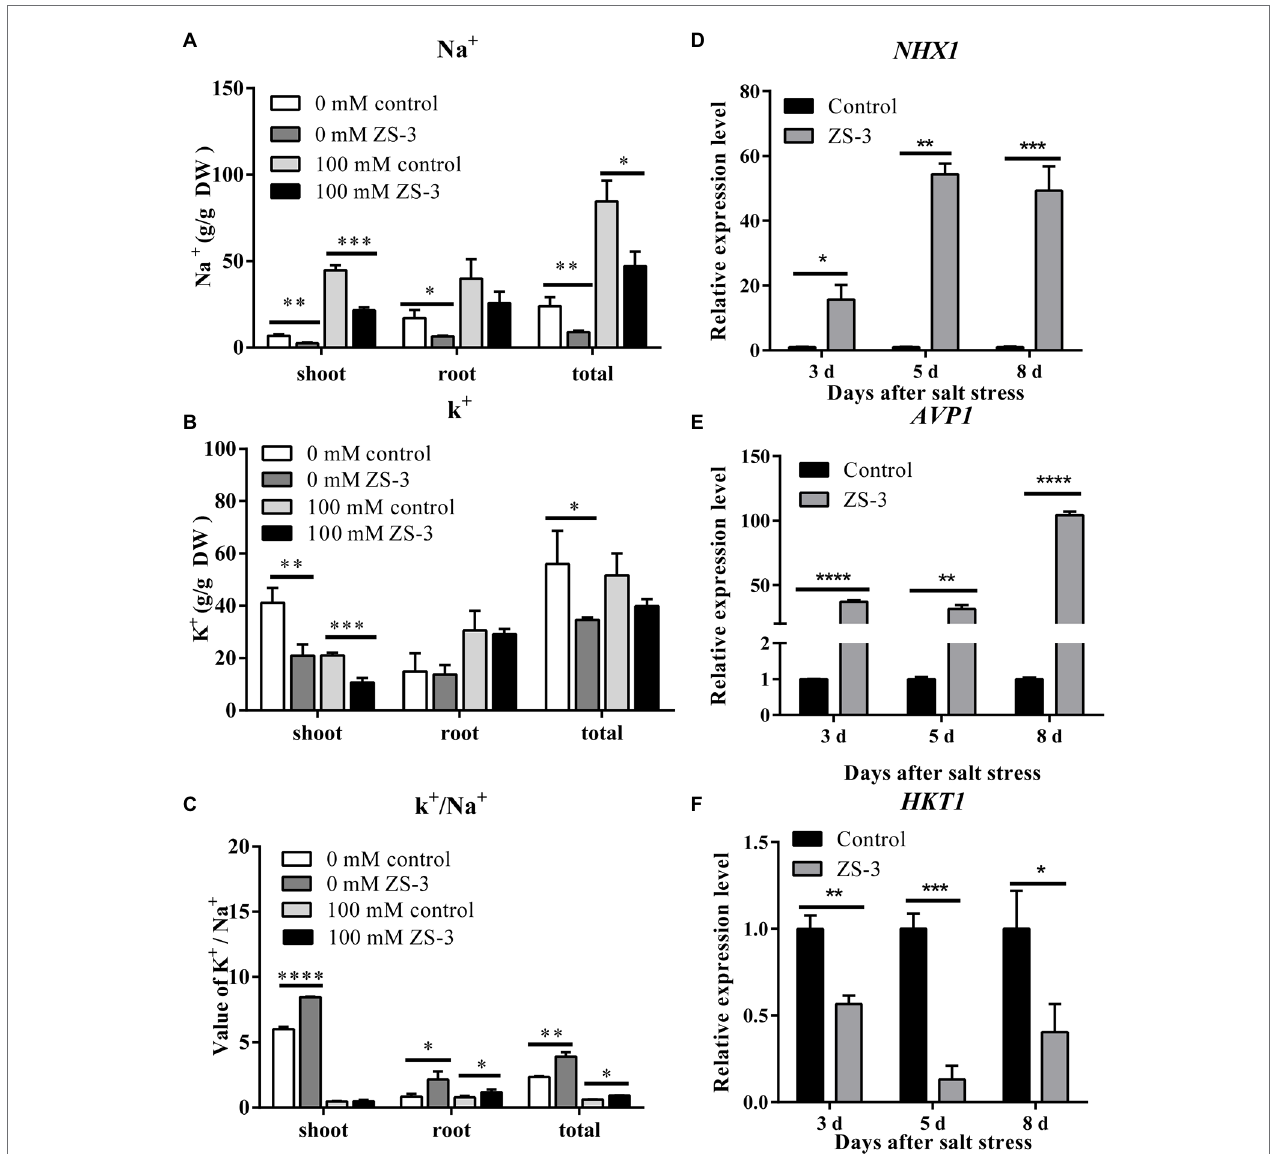
FIGURE 4 | Effect of inoculation with ZS-3 on ion uptake in Arabidopsis thaliana . Na + accumulation (A) , K + production (B) , and the K + /Na + ratio (C) in Arabidopsis thaliana roots and leaves were measured at 14 days after inoculation with strain ZS-3 in the absence or presence of 100 mM NaCl. The expression levels of the Arabidopsis thaliana defense-related genes NHX1 (D) , AVP1 (E) and HKT1 (F) were quantified by qRT–PCR at days 3, 5 and 8 after inoculation with strain ZS-3. Arabidopsis thaliana inoculated with inactivated bacterial dilutions was used as a control. The results are the means ± standard deviations from three independent experiments. Asterisks indicate significant differences between treatments according to Student’s t -test (* p < 0.05; ** p < 0.01; *** p < 0.001; **** p <